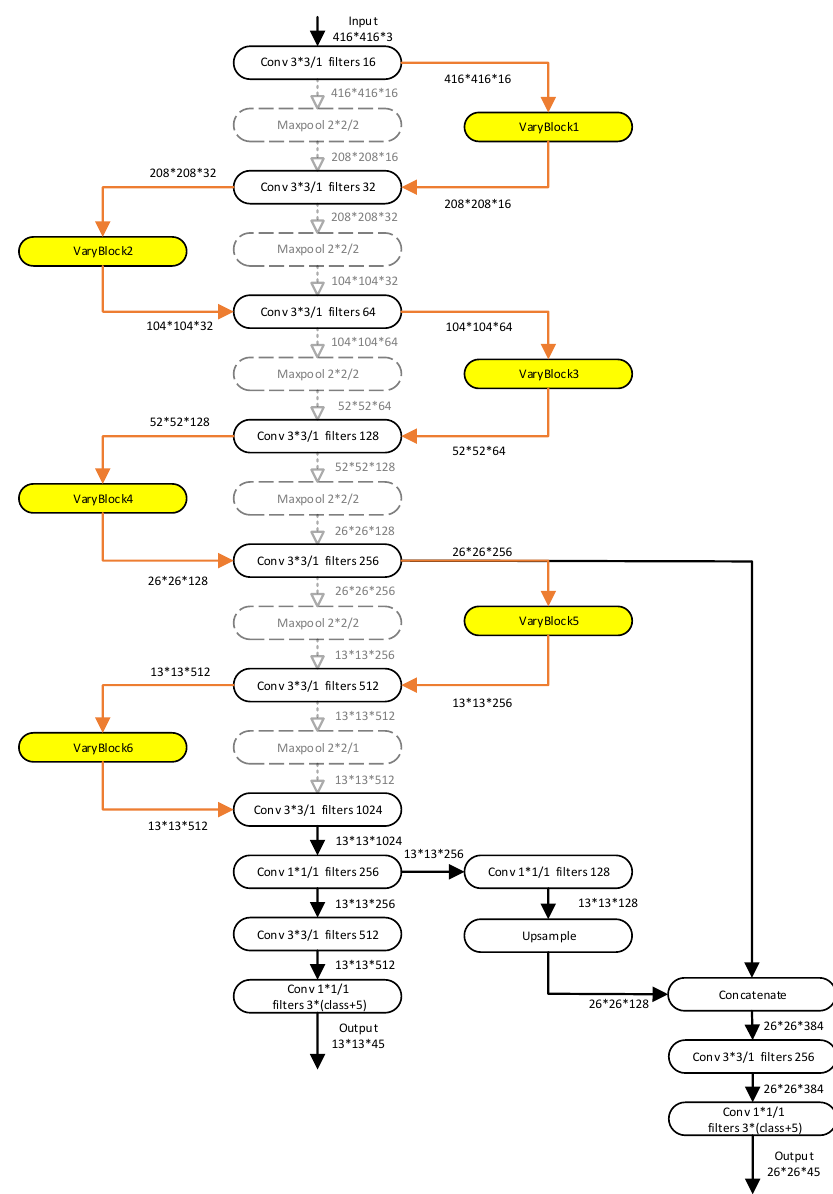
Figure 2. Network structure of the improved YOLO-Tiny(v3) object detection. The color part is the added module, the gray part is the replaced structure, and the rest is the reserved